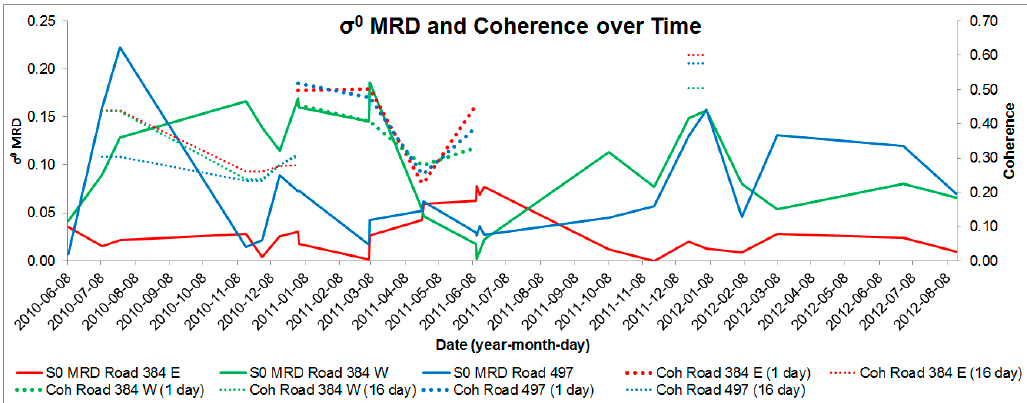
Figure 41. Graph showing contrast of σ 0 residues, as described in Figure 39, and coherence over each residue (in dotted lines). The coherence values are provided both for the master and the slaves of InSAR pairs. Where a master is also a slave, it takes the value of the slave.